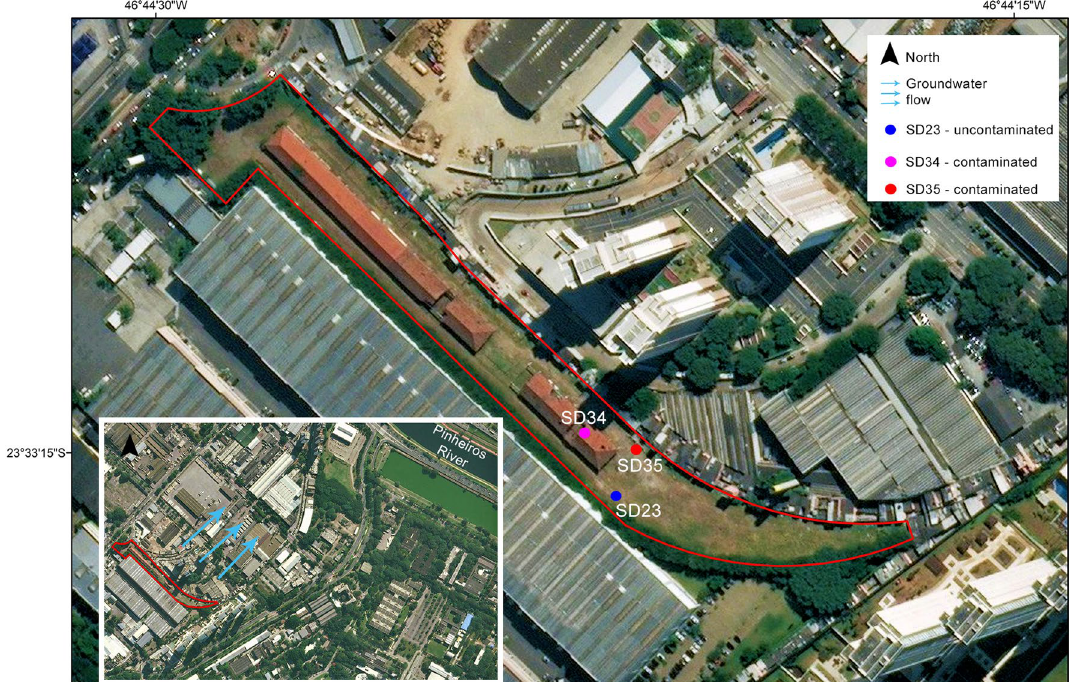
Figure 1. Study site with location of sampling wells and an indication of groundwater flow (blue arrows). The blue, magenta, and red dots correspond to the uncontaminated SD23 and contaminated SD34 and SD35 profiles, respectively. The inset figure shows the locations of Pinheiros river floodplain area that contributes to the subsurface stratigraphy. For the creation of the map, images obtained from the digital mapping of the city of São Paulo in 2017, available at (http:// geosa mpa. prefe itura. sp. gov. br/), were used, and the maps were generated in the ESRI ArcMap 10.6.0 program, designed in geographic coordinate system with WGS 84.